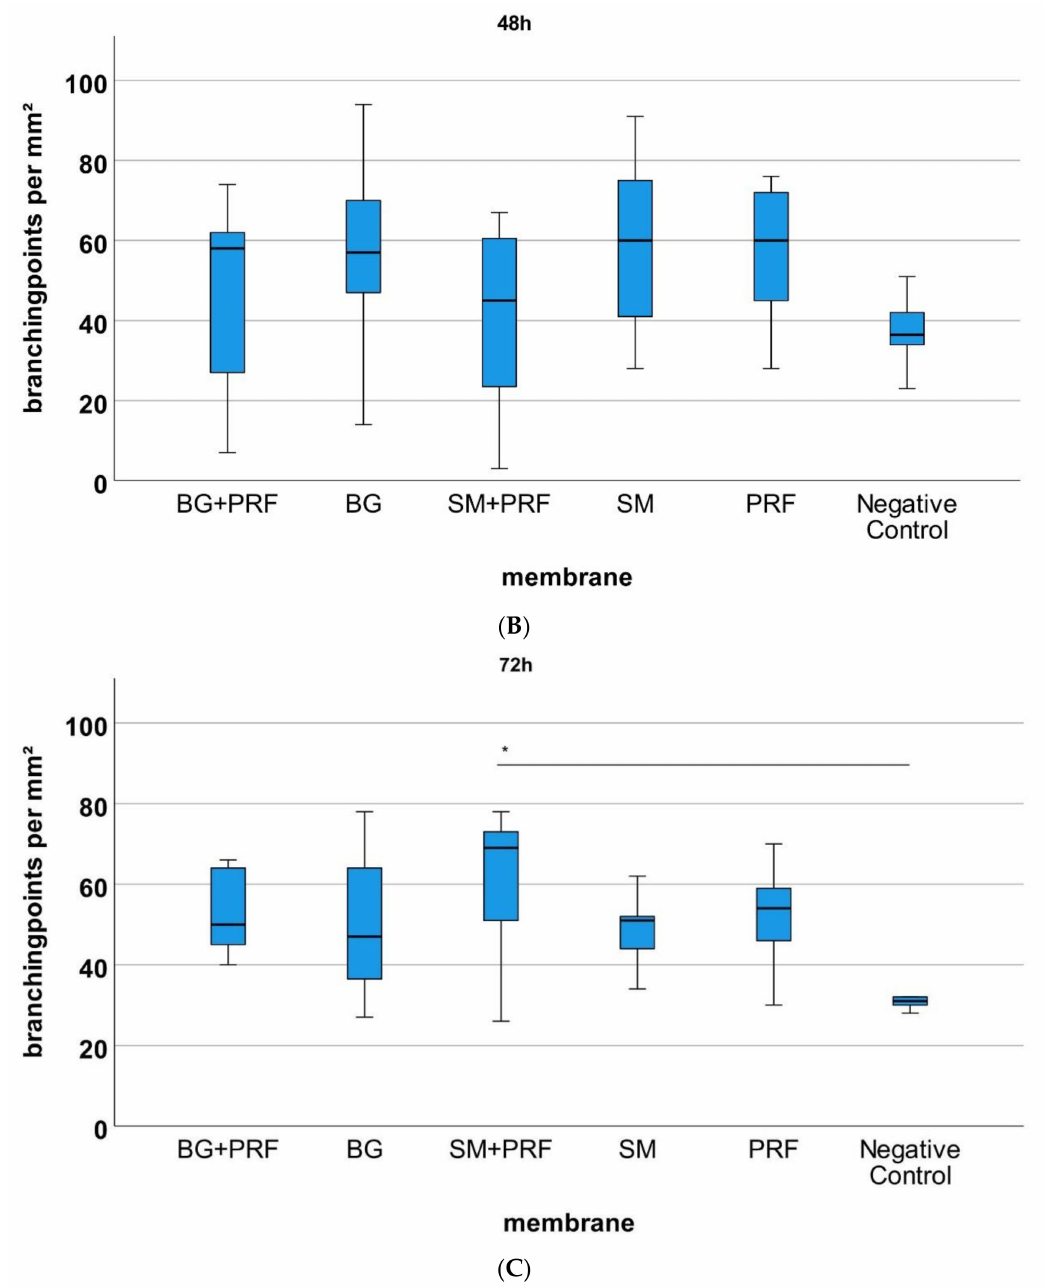
Figure 6. YSM assay and analysis of the branching points per mm 2 for the respective matrix (BG + PRF: Bio-Gide ® with PRF, BG: native Bio-Gide ® , SM + PRF: Symbios ® with PRF, SM: na- tive Symbios ® , PRF, negative control). ( A ) 24 h, ( B ) 48 h, ( C ) 72 h of incubation. * marks statistically significant differences ( p < 0.05; for details please see the responding